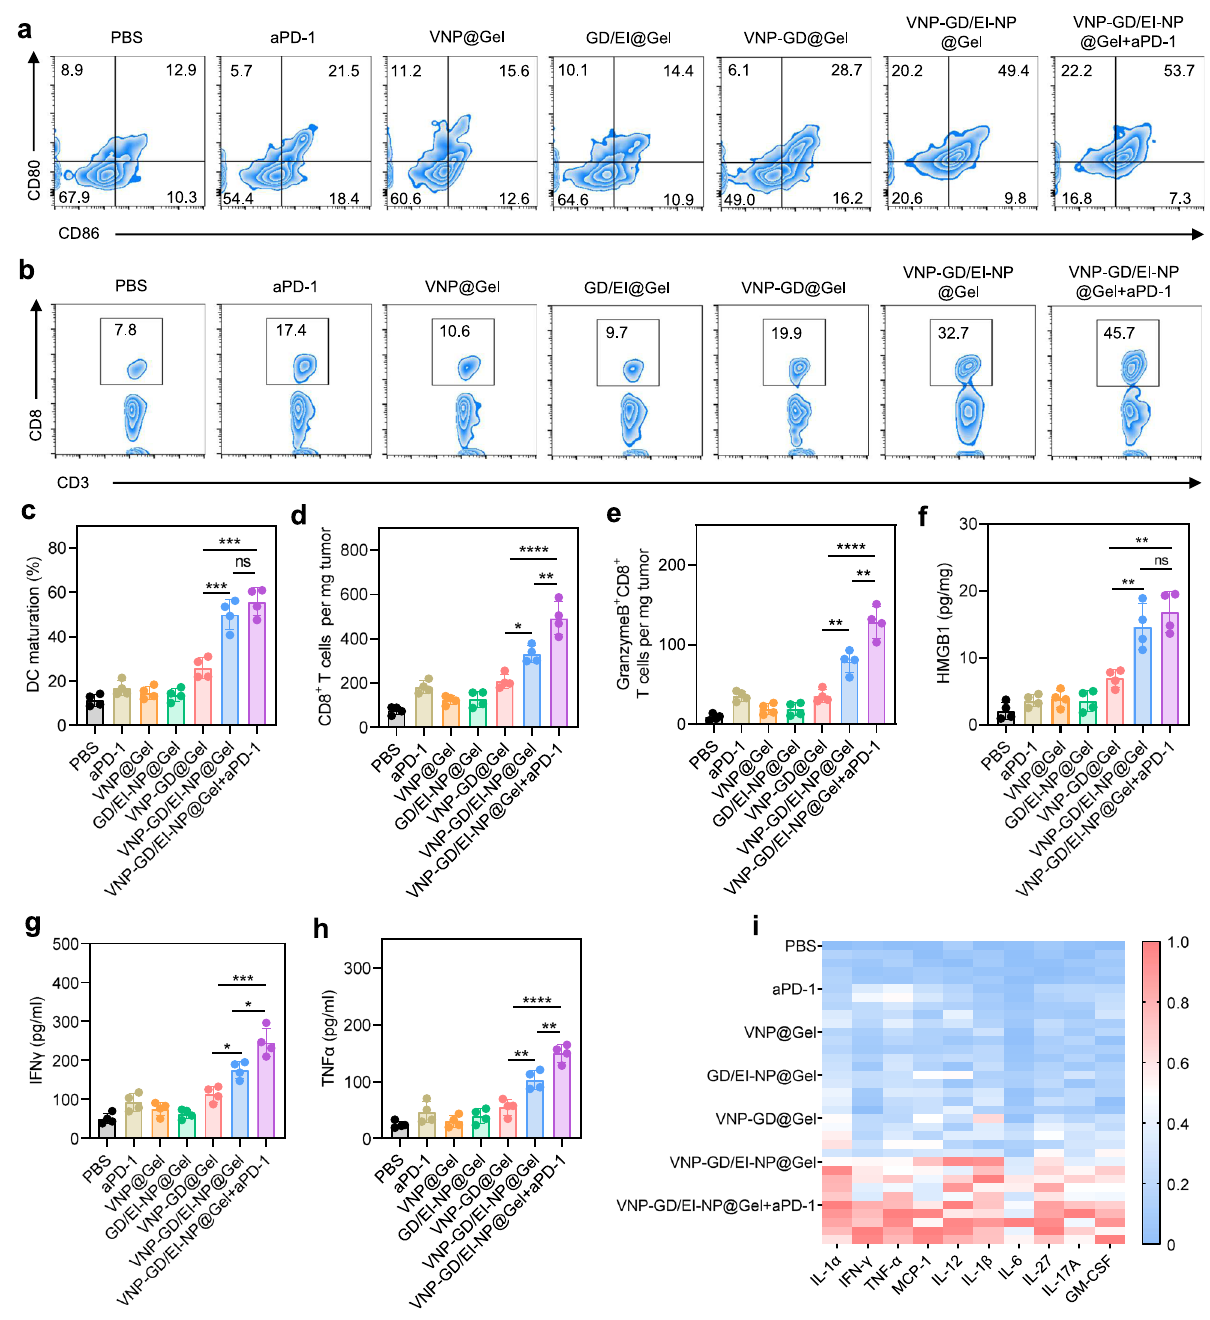
Fig. 5 | Preventing ESCRT-dependent cell membrane repair enhanced pyr- optosisandaugmentedantitumorimmuneresponse.a Flowcytometryassayof dendritic cell maturation in the lymph nodes after treatments with PBS, aPD-1, VNP@Gel, GD/EI-NP@Gel, VNP-GD@Gel, VNP-GD/EI-NP@Gel and VNP-GD/EI- NP@Gel+aPD-1( n =4mice). b FlowcytometryassayofCD8 + Tcellin fi ltrationinthe tumor tissue after treatments as mentioned above, n =4 mice. c Dendritic cell maturation in the lymph nodes after different treatments. Data are shown as mean±s.d. and analyzed with one way ANOVA followed by Tukey ’ s multiple comparisons test, n =4 mice (VNP-GD@Gel vs. VNP-GD/EI-NP@Gel: *** P =0.0008; VNP-GD@Gel vs. VNP-GD/EI-NP@Gel+aPD-1: *** P =0.0002; VNP-GD/EI-NP@Gel